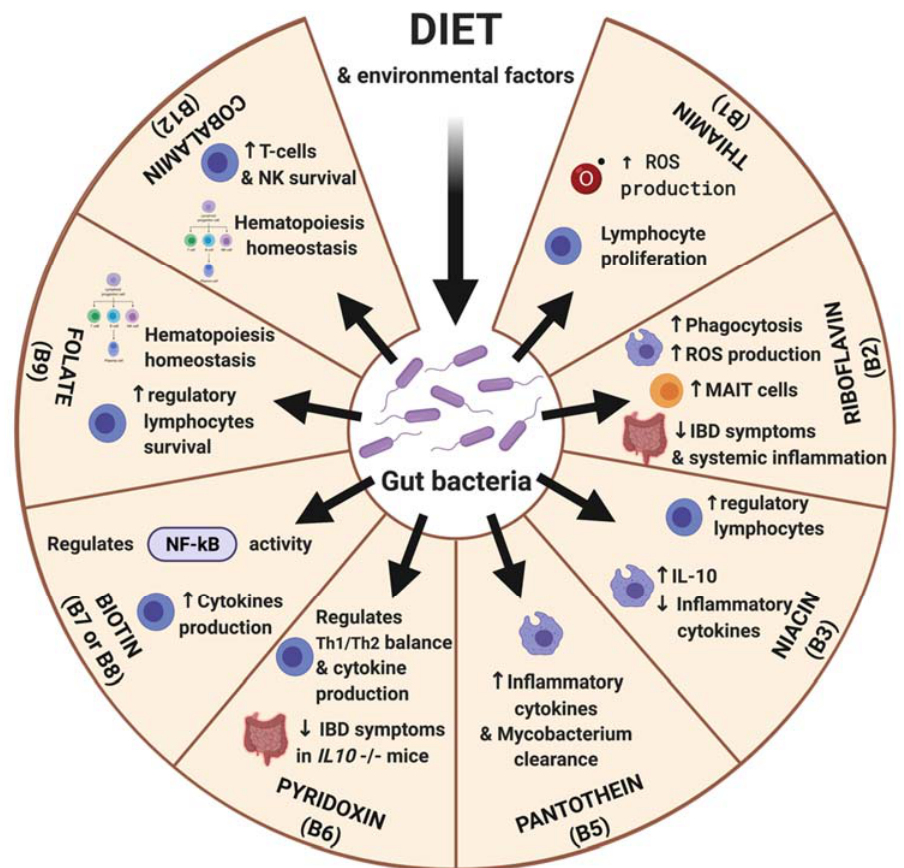
Figure 2. Overview of the impact of the different B vitamins on immunity. The main source of VB is the dietary intake, together with modification of dietary precursors or de novo synthesis carried out by the microbiota. As VB plays a role as precursors or as enzyme cofactors in numerous metabolic reactions, they impact the regulation of immune homeostasis through the metabolism, which is summarized here for each VB. MAIT, mucosa-associated invariant T lymphocytes; IBD, inflammatory bowel disease; ROS, reactive oxygen species).